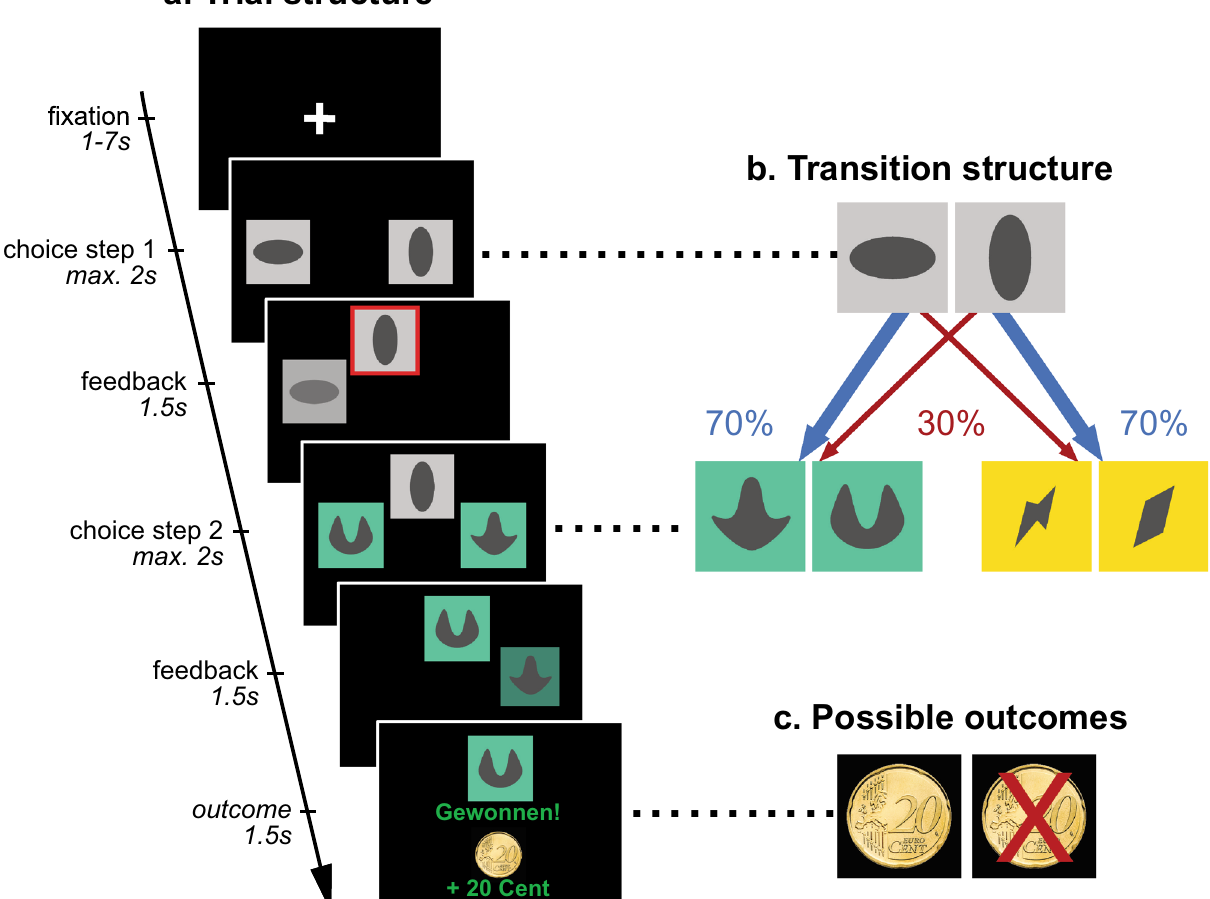
Figure 1. The two-step task 25,30 . ( a ) Trial structure of an example trial with a rare transition, which allows for the dissociation of model-based and model-free control of behaviour. ( b ) Transition structure showing how each first-stage stimulus (grey) leads to one of the two second-stage stimulus pairs (green or yellow) in 70% of the trials (common, blue arrows) and to the other pair in 30% of the trials (rare, red arrows). ( c ) Possible outcomes (reward, no reward). Reward probability for the four second-stage stimuli varies throughout the task according to random walks to encourage continuous